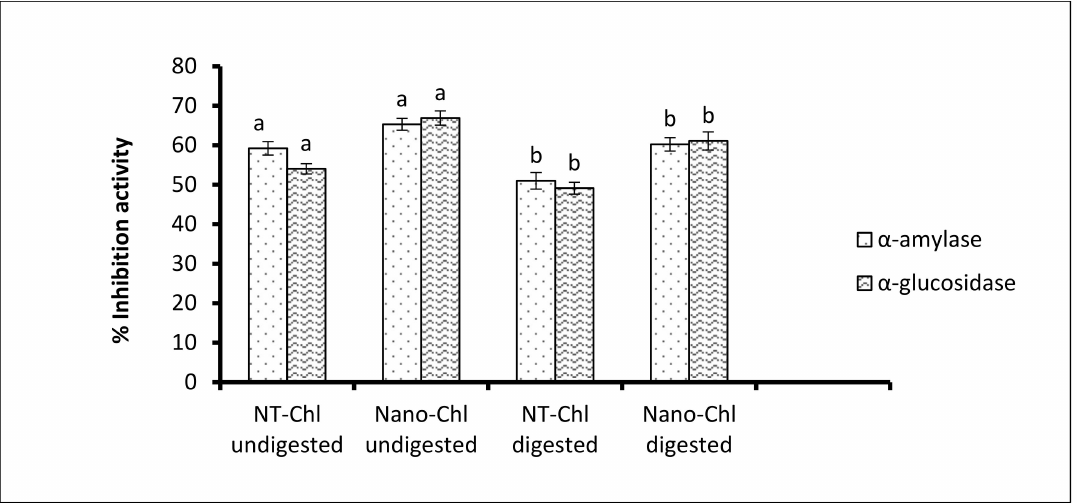
Figure 5. Antidiabetic activity of the NT-Chl and Nano-Chl. Bars represent standard deviation (n = 3). Different letters on the bars representing same enzyme treatments and encapsulation methods indicate significant differences ( p <0.05). Key: For caption, see Figure 3.